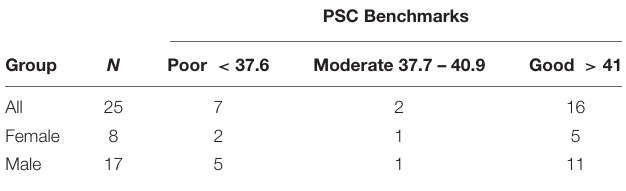
TABLE 4 | Psychosocial safety climate-12 benchmarks.